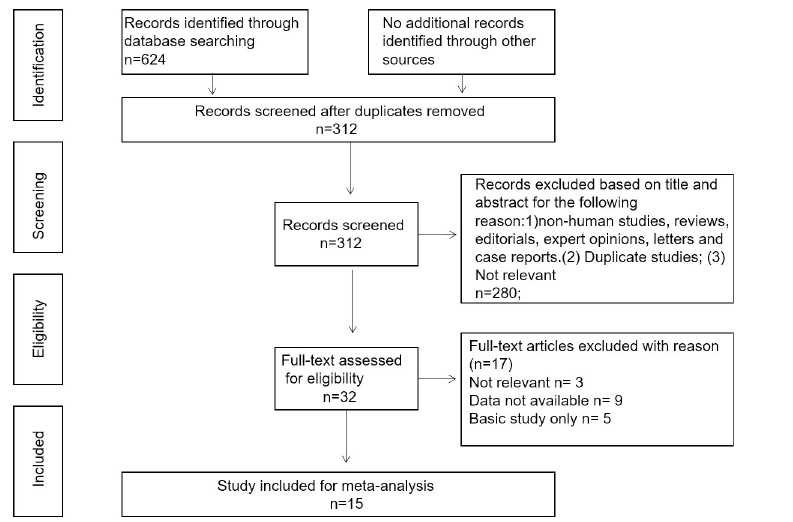
Fig 1. Flow diagram of the study search and selection process.